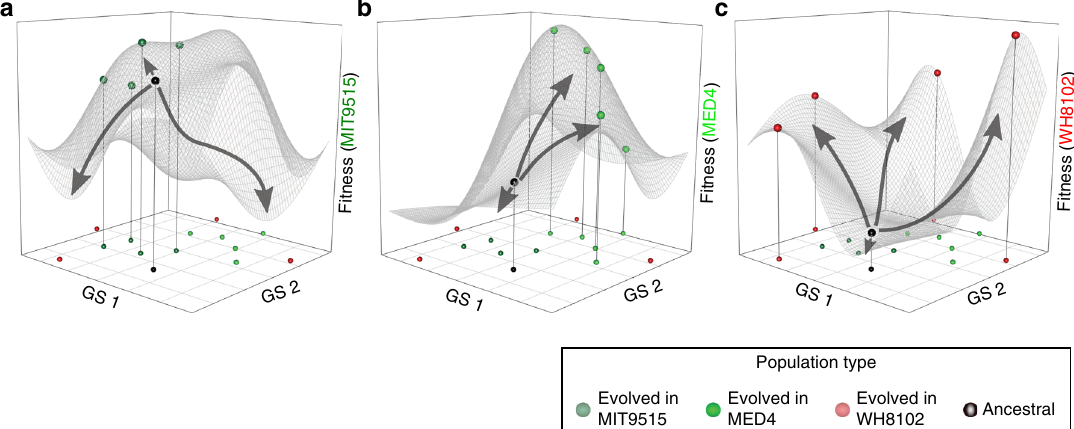
Fig. 6 Model for the in fl uence of different hosts on the evolution of viral populations. Each panel represents the infectivity landscape of the evolved and ancestral phage populations when infecting a the optimal host, Prochlorococcus MIT9515, b sub-optimal host Prochlorococcus MED4, and c sub-optimal host Synechococcus WH8102. In all infectivity landscapes the GS1~GS2 plane (GS, Genomic Space) is identical and corresponds to pair-wise genetic distances between populations. The Z -axis shows the fi tness of phage populations, based on the ability to infect each host (see Methods). Predicted fi tness surfaces (mesh over the genomic plane) were calculated based on the infectivity of all phage populations when infecting each of the cyanobacterial hosts. Spheres located on the GS1~GS2 plane show the location of each phage population in the genotypic space. Only the ancestral population and the populations that evolved in the host used to measure the infectivity appear as spheres on the fi tness surface. When the optimal host is abundant, phage proliferation occurs mainly by infections of this host (panel a ). The fi tness of the ancestral population is high and most mutations result in lower fi tness, and are therefore puri fi ed by negative selection (downwards arrows). Only a few mutations result in higher fi tness and are positively selected (upwards arrow). Therefore, the evolved populations remain close to the ancestral population, both genotypically and phenotypically. Upon reduction in the abundance of this host, infections of “ sub-optimal ” hosts become frequent (panel b ). When the fi tness of the ancestral phages on this host is lower, compared to the fi tness in the optimal, phage evolution on sub-optimal hosts results in a higher fraction of positively selected mutations, increased fi tness of evolved populations and higher genotypic diversi fi cation. Often the only potential host is poorly infected by the ancestral phage (panel c ). When the ancestral population evolves in this host, high numbers of mutations are positively selected, leading to rapid divergence into distinct phage populations, both phenotypically and genotypically. This demonstrates how the type of bacterial host impacts the diversity of phage populations. Raw data can be found in